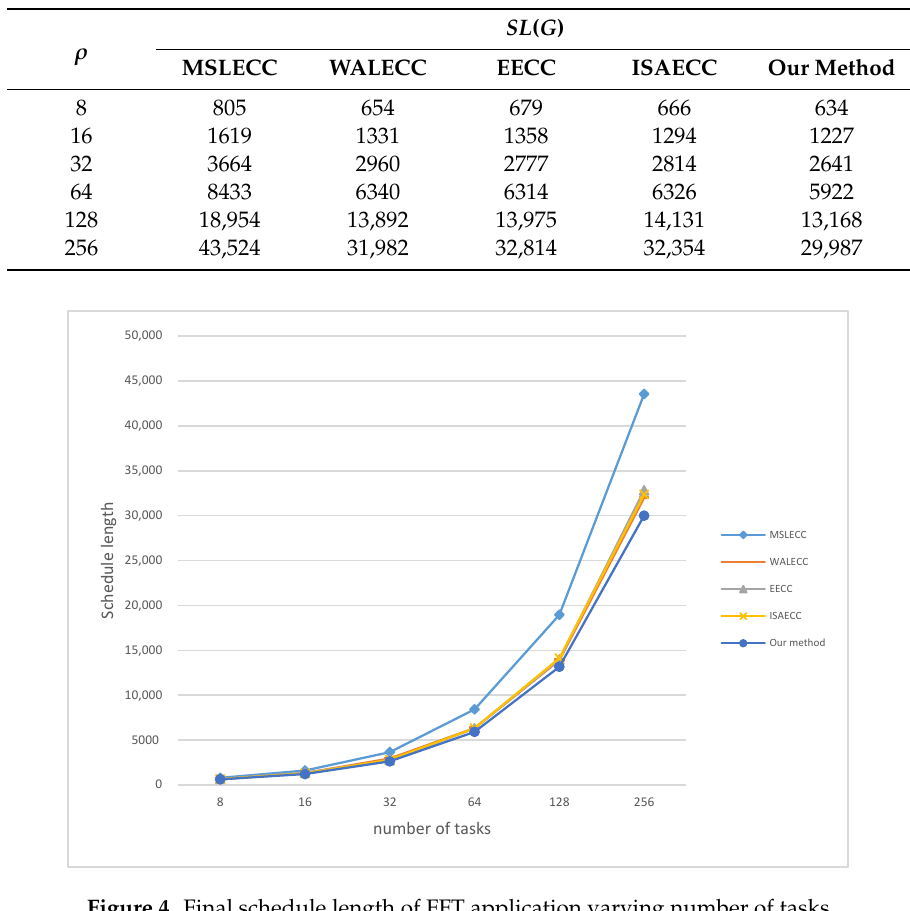
13 Figure 5. Gaussian elimination (GE) application model with 𝜌 = 5 .